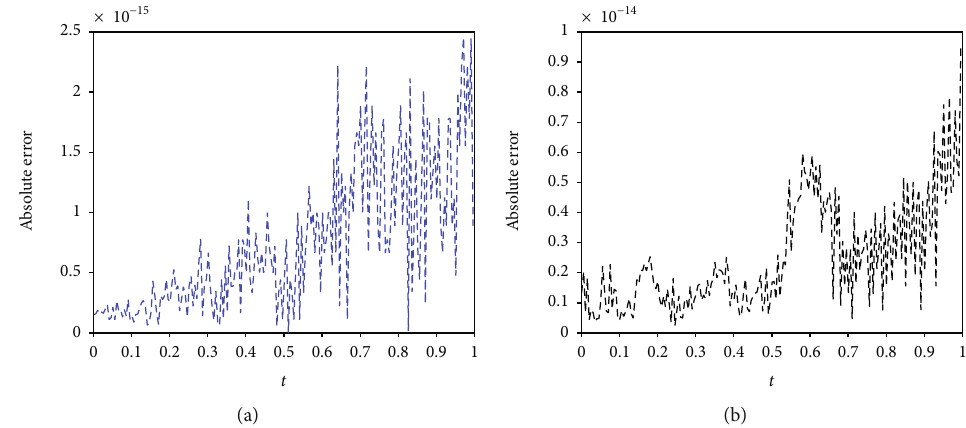
Figure 10: In (a), for β = 1 and t ∈ ½ 0, 1 (cid:2) , the error function of ζ ð t Þ corresponding to Problem 5 is shown. error function of ζ 2